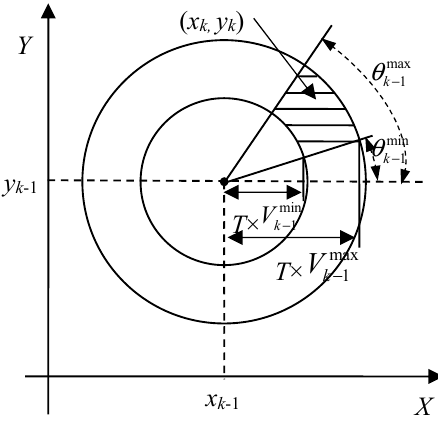
Figure 4. Constrains of carrier’s movement on the matching results.